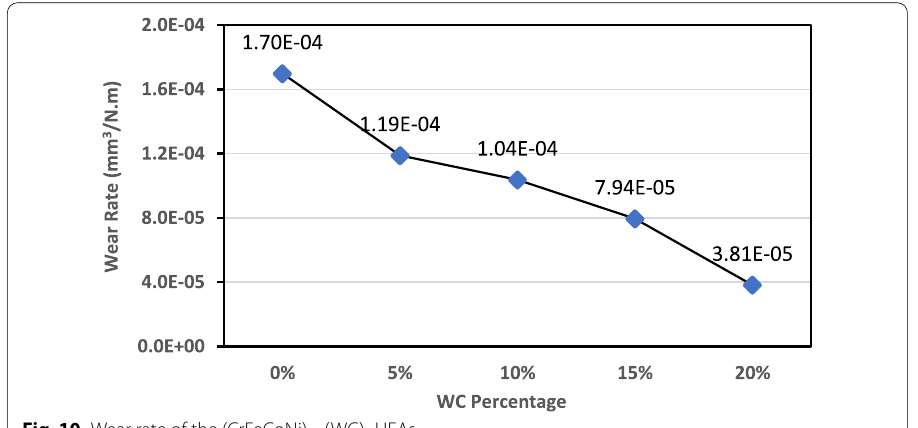
Fig. 10 Wear rate of the (CrFeCoNi) 1-x (WC) x